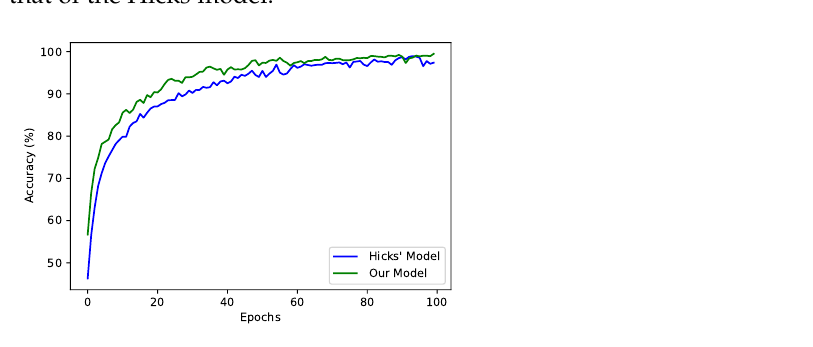
Figure 5. Our proposed model compared with Hicks’s model. Both implementations are trained on the 5K EPP